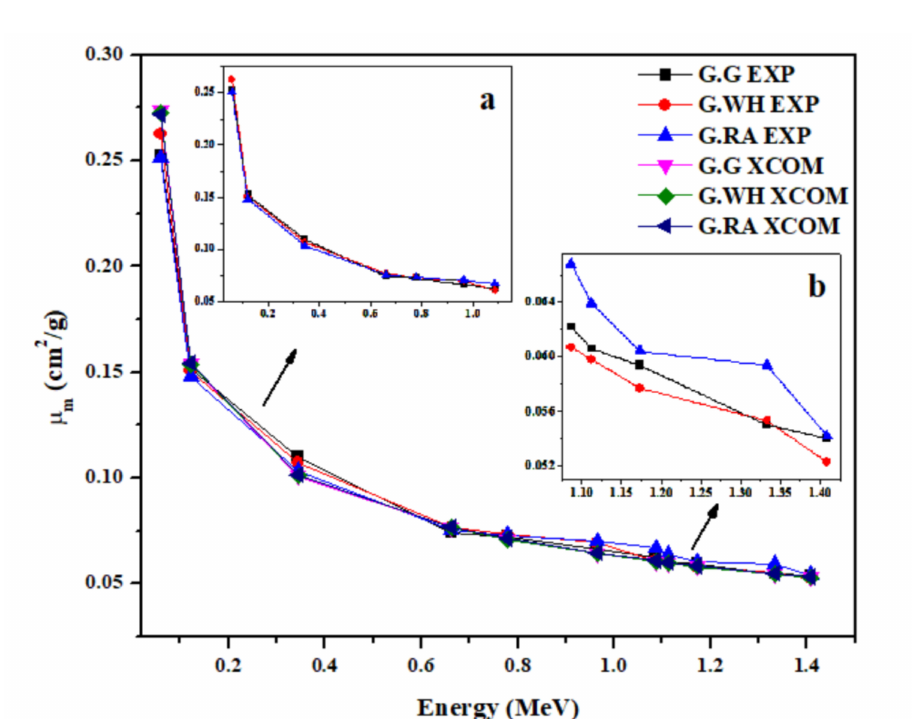
Figure 2. Variation of the experimental and theoretical values of the mass attenuation coefficient ( µ m ) with photon energy for the granite samples in the energy range 0.015 to 15 MeV. Insets ( a , b ) to the figure show the variation of the experimentally obtained µ m in the low and high energy ranges,